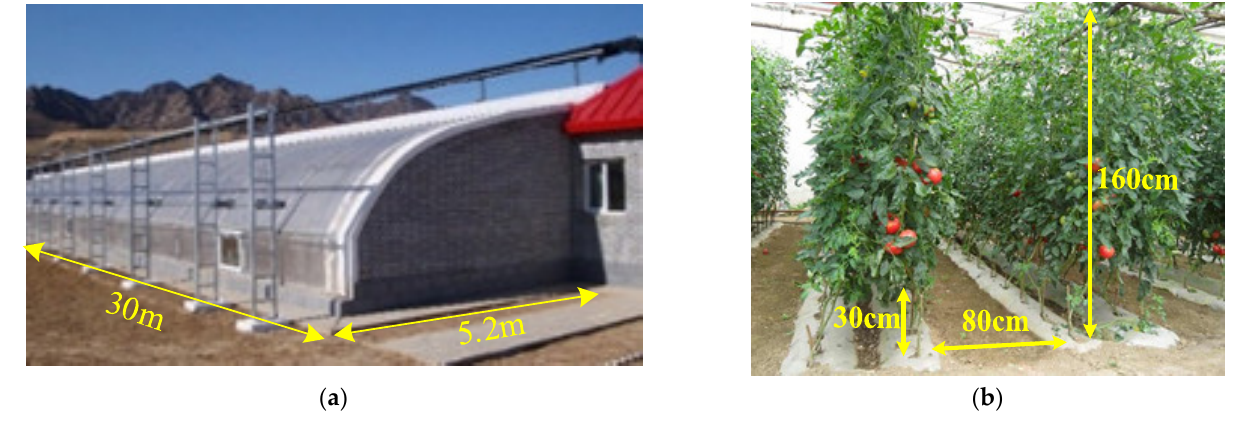
Figure 1. Solar greenhouse. ( a ) The appearance of the solar greenhouse; ( b ) Tomato planting environment in greenhouse.